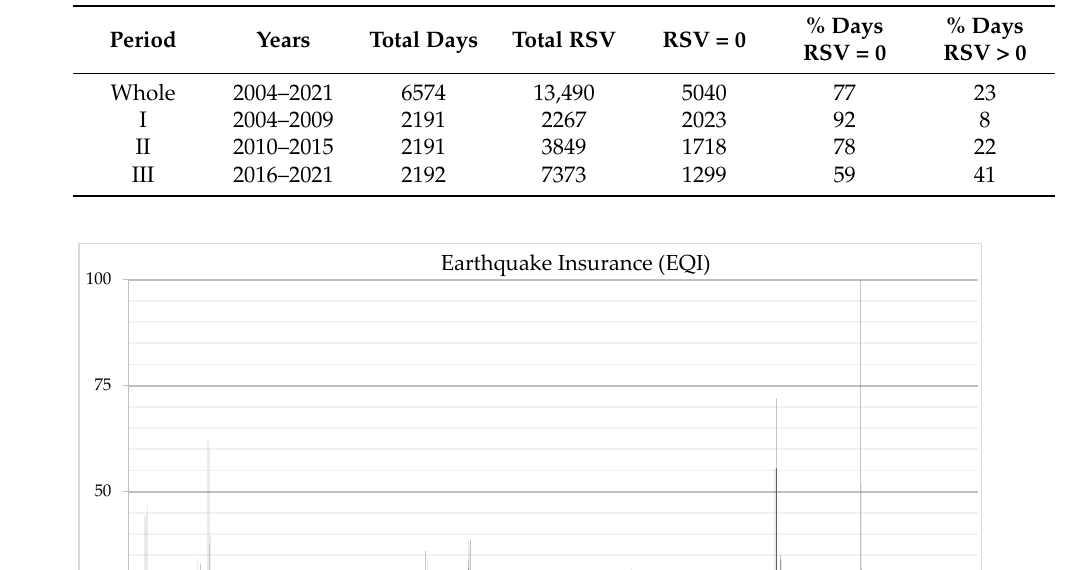
Table 1. Google Trends interest in earthquake insurance in California. The main statistical data for the whole time span and for each of three periods.